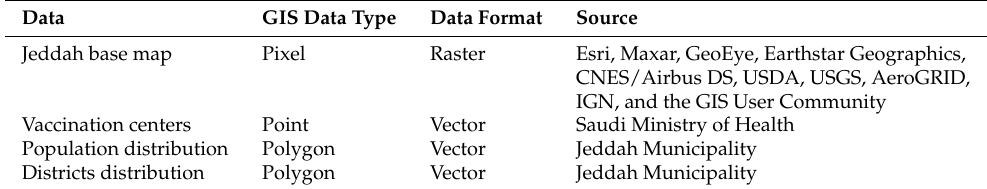
Table 1. A description of the spatial data for COVID-19 vaccination centers in the city of Jeddah.